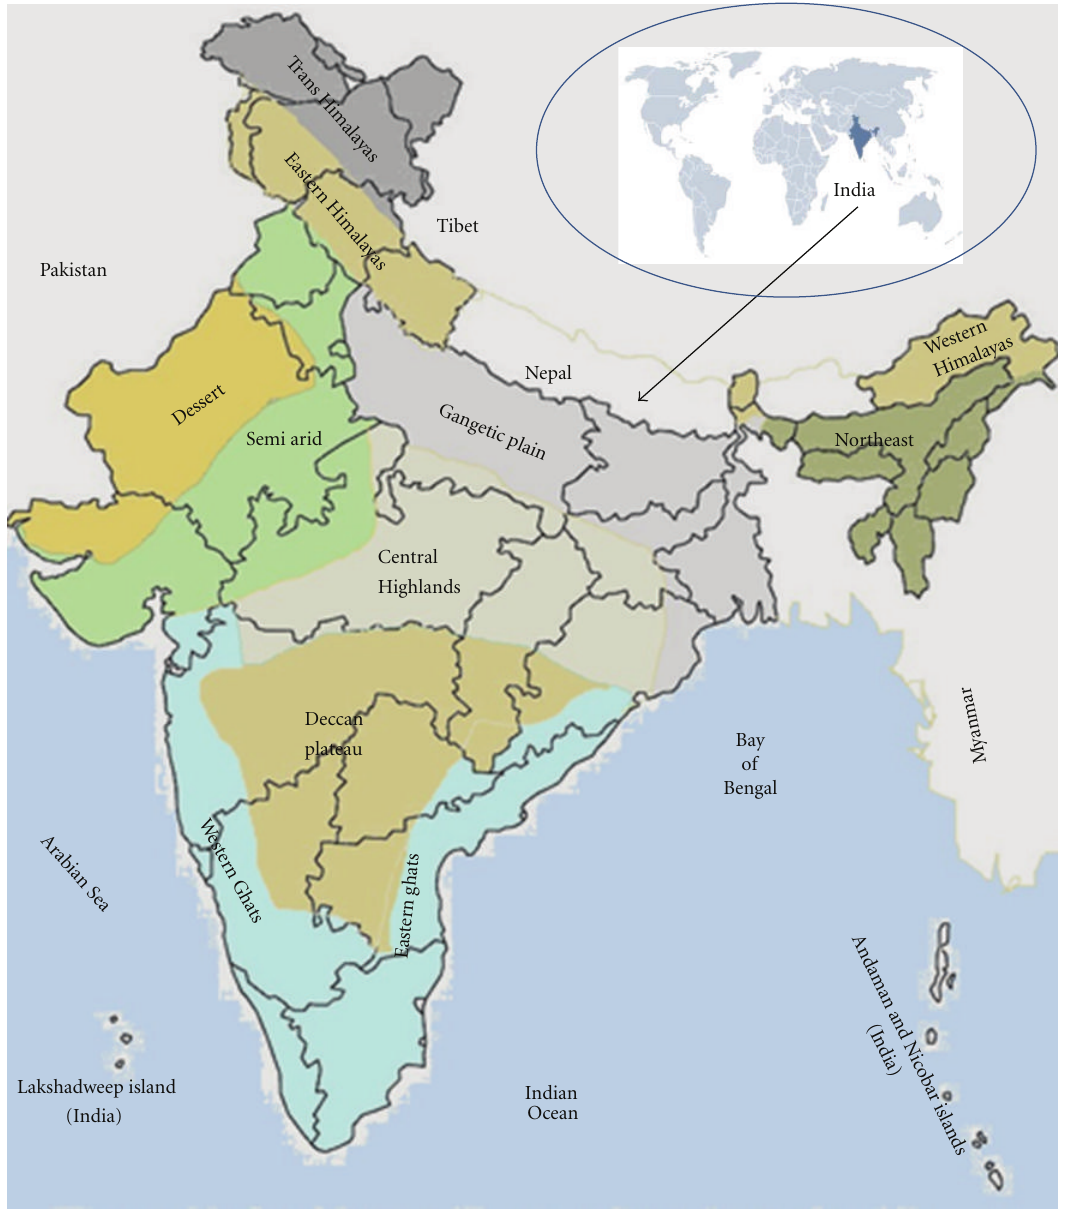
Figure 1: Di ff erent biodiversity zones of Indian subcontinent from where 23 plant species were